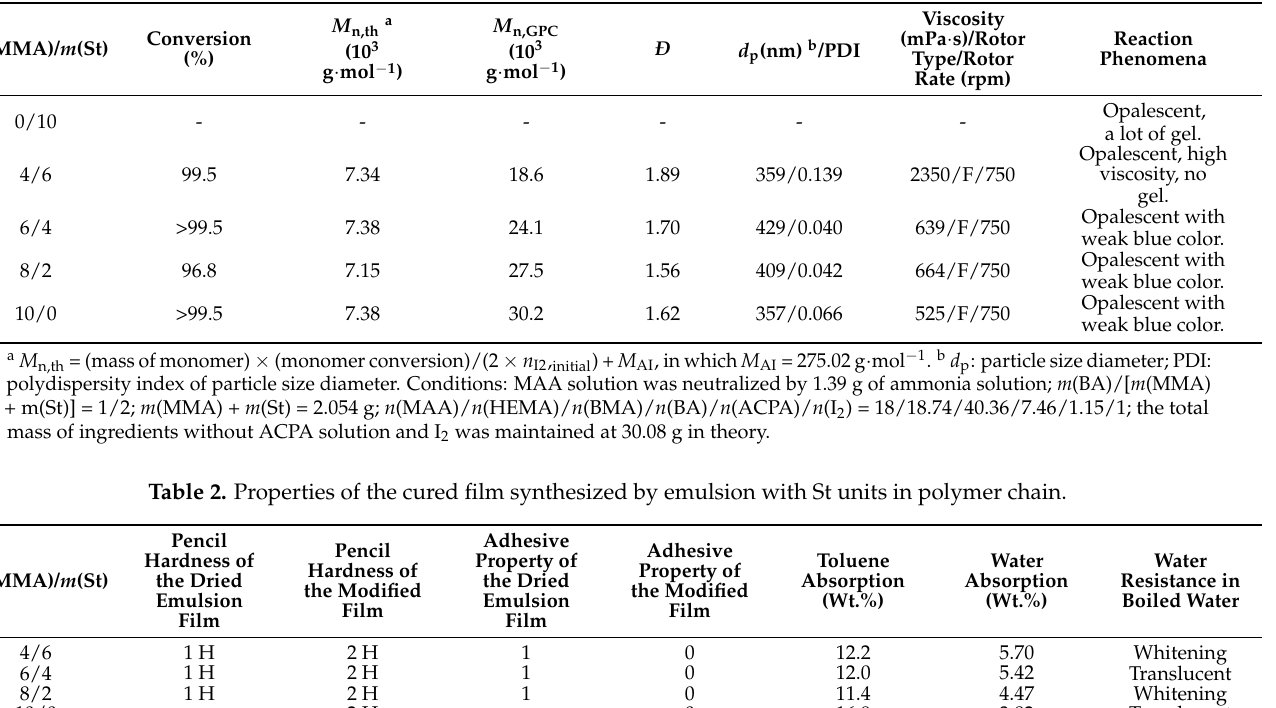
Table 1. Results of emulsion with St units in polymer chain.